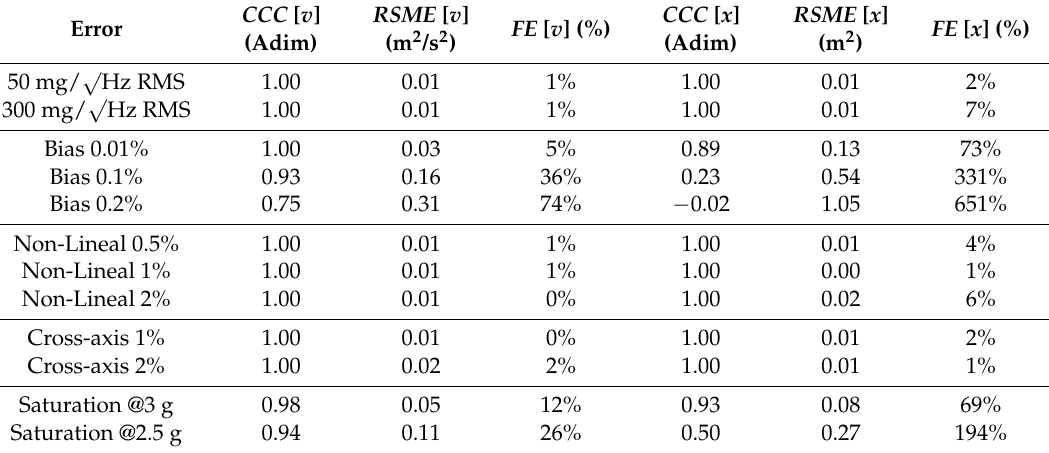
Table 2. Quality indicators in the Z axis signal calculations by error; velocity [ v ] and displacement [ x ]. CCC [ v Error